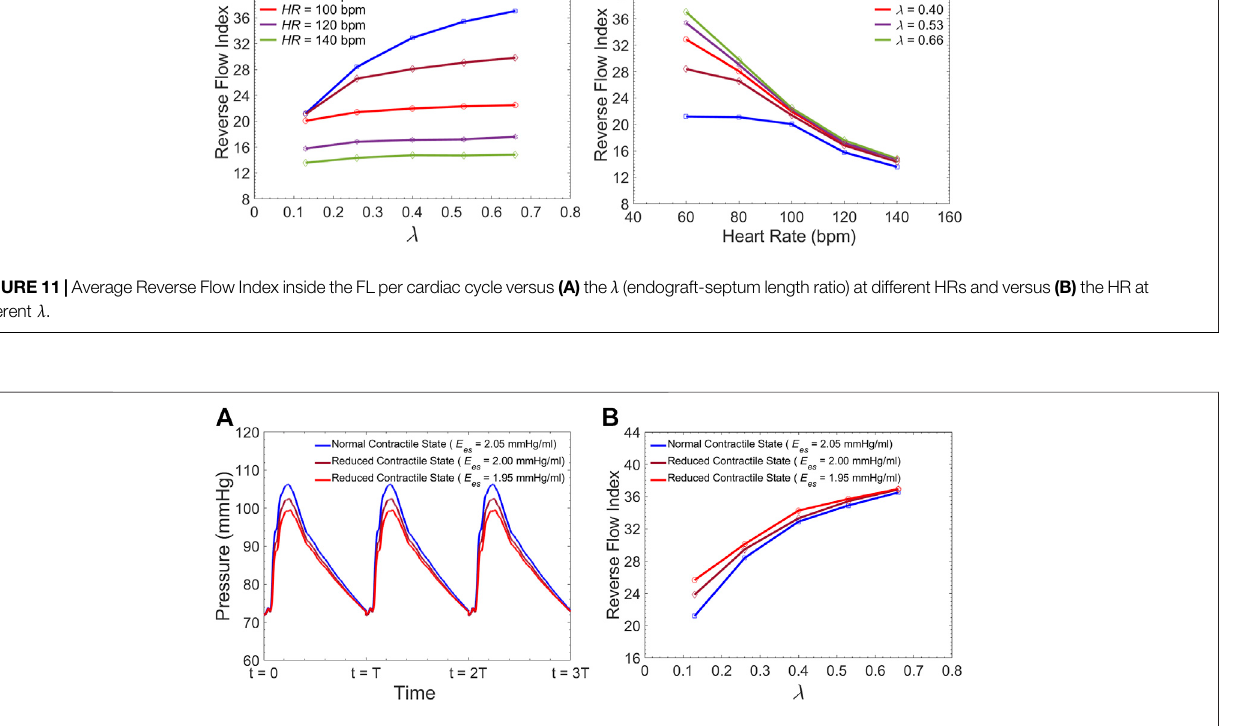
FIGURE12|(A) SimulatedpressureinsidetheTLatzone4fordifferentlevelsofLVcontractility,and (B) AverageReverseFlowIndexinsidetheFLpercardiaccycle versusthe λ (endograft-septumlengthratio)at differentlevelsofLVcontractility. E es (cid:1) 2 . 05mmHg/mlcorresponds to CO (cid:1) 5 . 7l/min, E es (cid:1) 2 . 00mmHg / mlcorresponds to CO (cid:1) 5 . 2l/min, and E es (cid:1) 1 . 95mmHg/ml corresponds to CO (cid:1) 4 .